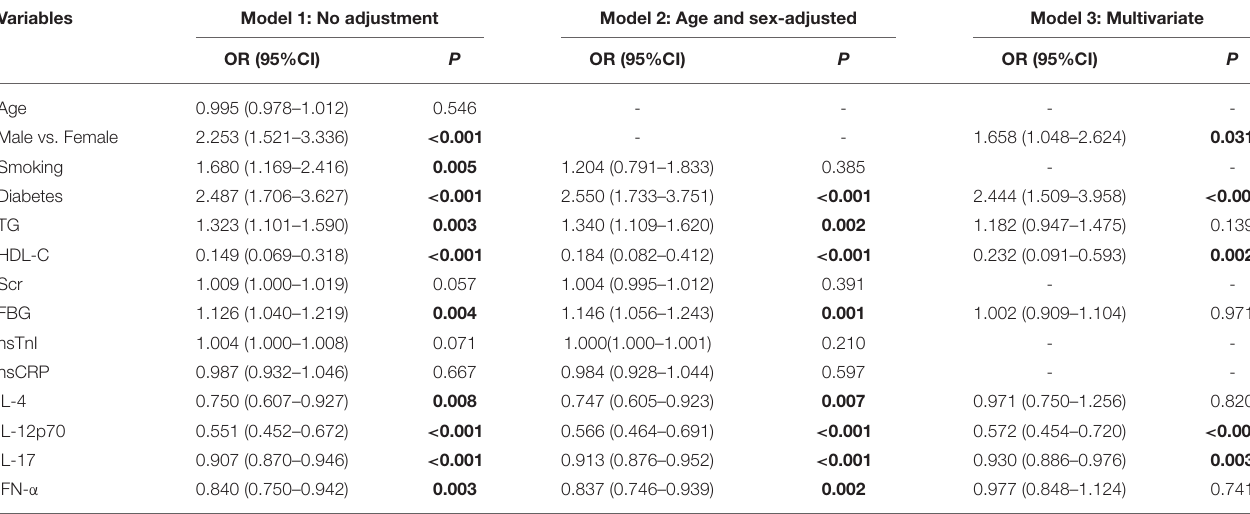
TABLE 2 | Logistic regression analysis to predict severe CAD. Variables